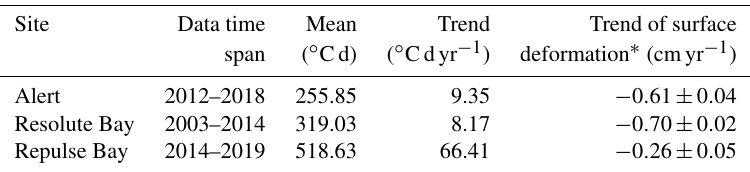
Figure 6. Surface elevation changes in each thaw season in Resolute Bay during 2003–2014. Red dots denote the measurements in the thaw seasons. Grey error bars denote the uncertainties. The mean value of the measurements has been removed. The shorter thaw season in 2013 was due to the late thawing onset on DOY 181 and early freezing onset on DOY 227, estimated from air temperature and snow depth records. Table 3. Basic statistics of annual DDT at Alert, Resolute Bay, and Repulse